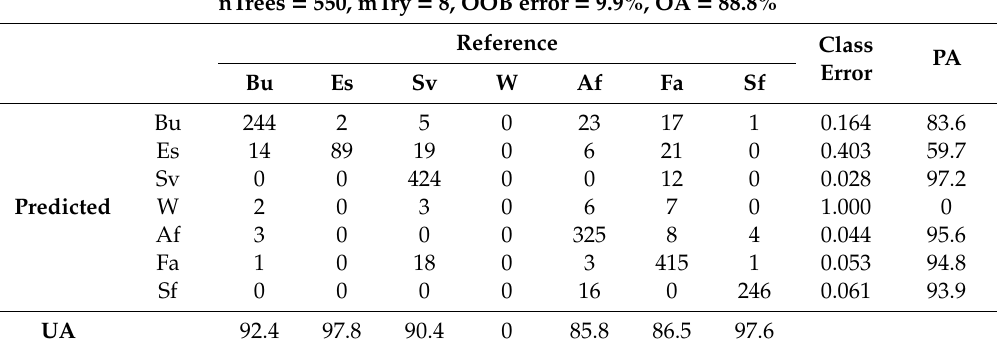
Table A2. The classification confusion matrix of the GL3_B6 Model. OA, Overall Accuracy; UA, User Accuracy; PA, Producer Accuracy.